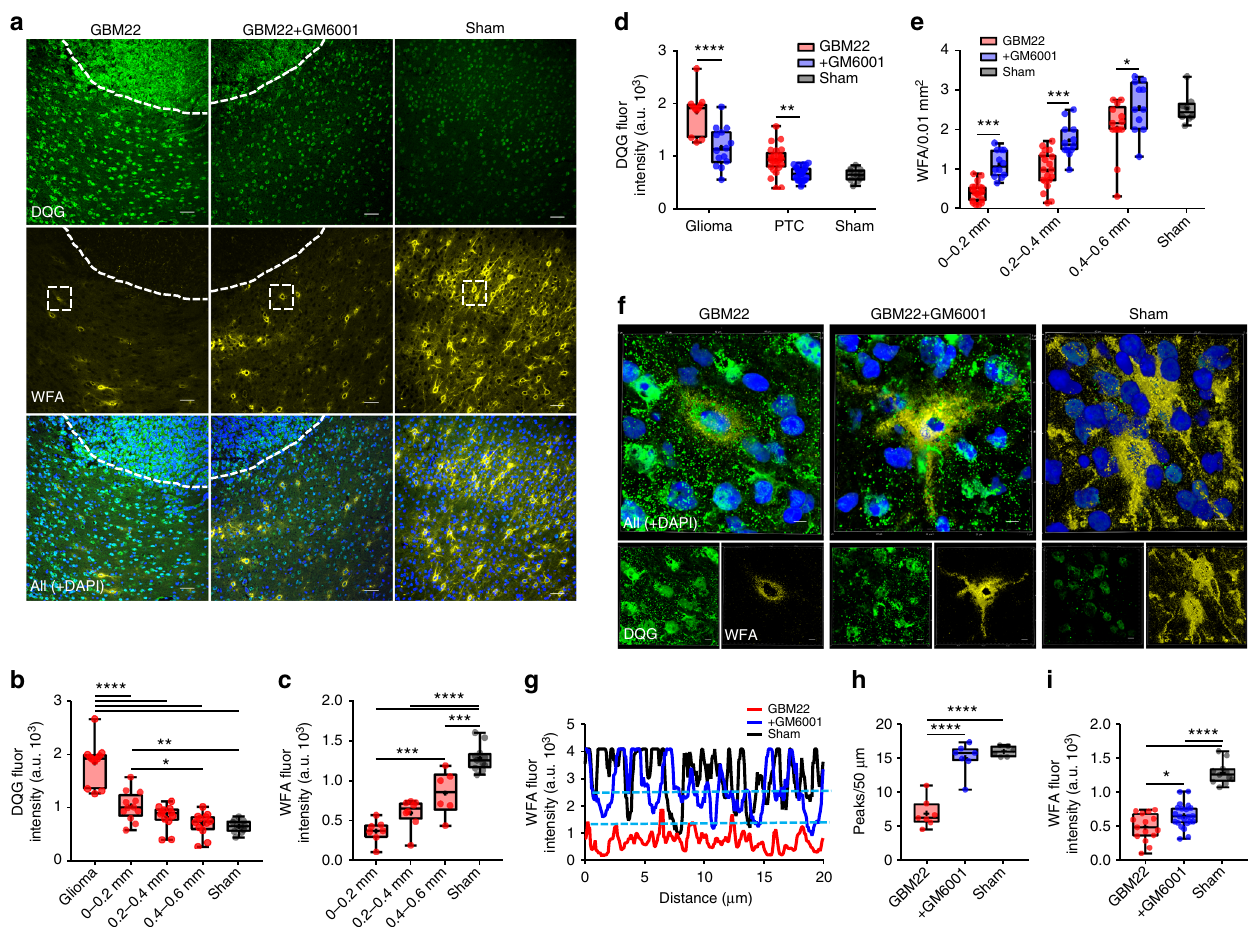
Fig. 5 PNN degradation by glioma-released proteases. a Representative images showing gelatinase activity (DQG-green), DAPI (blue), and PNN (WFA- yellow) immuno fl uorescence in GBM22 PTC (left), GM6001-treated glioma-implanted PTC (GBM22 + GM6001, middle), and sham (right) cortical sections. Scale = 50 µ m. b Mean gelatinase activity in glioma mass (delimited by dashed line in ( a )) (1851.47 ± 120.17), 0 – 0.2 mm (1048.74± 79.63), 0.2 – 0.4 mm (848.61 ± 64.25), and 0.4 – 0.6 mm (715.96 ± 61.89) PTC and sham (669.96 ± 34.56). n = 6 mice. c WFA fl uorescent intensity at 0 – 0.2 mm (372.65 ± 54.10), 0.2 – 0.4 mm (599.17 ± 64.94), 0.4 – 0.6 mm (849.07 ± 113.94) PTC and sham (1282.73 ± 49.03). n = 5 mice. d Mean gelatinase activity in glioma mass (GBM22, 1851.47 ± 120.17; + GM6001, 1189.96 ± 98.43) and PTC (GBM22, 948.68 ± 54.21; + GM6001, 692.80 ± 23.61) was signi fi cantly lower in GBM22 + GM6001 group (also referred as + GM6001) than the GBM22 (nontreated) counterparts. n = 5 mice. e PNN numbers in + GM6001 group were signi fi cantly higher in 0.0 – 0.2 mm (GBM22, 0.43 ± 0.05; + GM6001, 1.14 ± 0.09), 0.2 – 0.4 mm (GBM22, 0.98 ± 0.10; + GM6001, 1.73 ± 0.12) and 0.4 – 0.6 mm PTC (GBM22, 2.05 ± 0.19; + GM6001 2.58 ± 0.19). n = 5 mice. f Representative 3D volume projections from within 0 – 0.4 mm PTC (dotted square in ( a )) showing gelatinase activity (DQG) and PNN architecture (WFA) in GBM22, + GM6001 and sham groups. Scale = 5 µ m. g Line intensity pro fi le of a single PNN (in f ) shows high intensity WFA peaks in GBM22, + GM6001 and sham groups. Dashed lines represent the threshold (50% of max WFA intensity) for WFA peak counts (in h ). h Mean WFA peaks in PNNs from GBM22 (7.08 ± 0.63), + GM6001 (15.16 ± 0.65) and sham (16.05 ± 0.53). Data of GBM22, + GM6001, and sham are from 20, 22, and 17 PNNs, respectively ( n = 4 mice). i Mean WFA fl uorescence intensity in + GM6001 PTC was higher than GBM22 PTC ( + GM6001, 656.96 ± 37.77; GBM22, 493.46 ± 51.21). n = 6 mice. PTC data in ( d ), ( h ), and ( i ) are from within 0 – 0.4 mm of tumor border. **** P < 0.0001, *** P < 0.001, ** P < 0.01, * P < 0.05, one-way ANOVA, Tukey ’ s post-hoc test in ( b , c, h, i ); two-way ANOVA, Sidak ’ s post-hoc test in ( d , e) . All fl uorescence intensities represent arbitrary units of fl